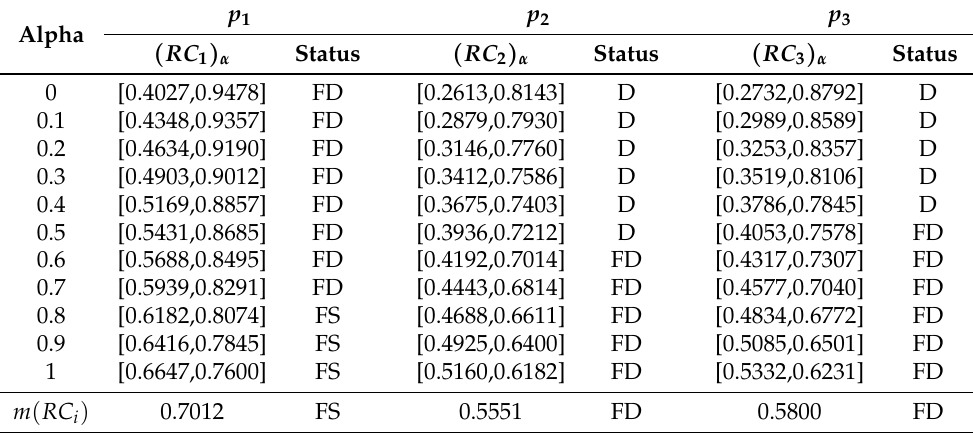
Table 12. The fuzzy relative closeness RC i and related status